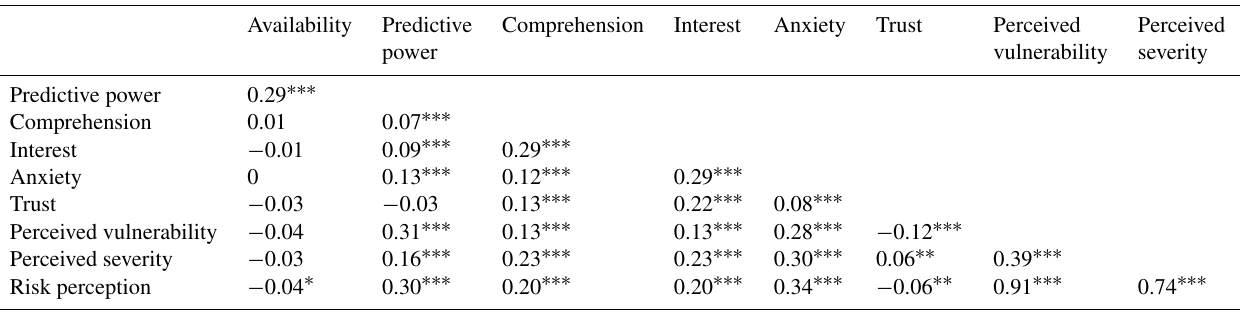
Table 4. Correlation matrix of cognitive and psychological factors with the risk perception indicators. Availability Predictive